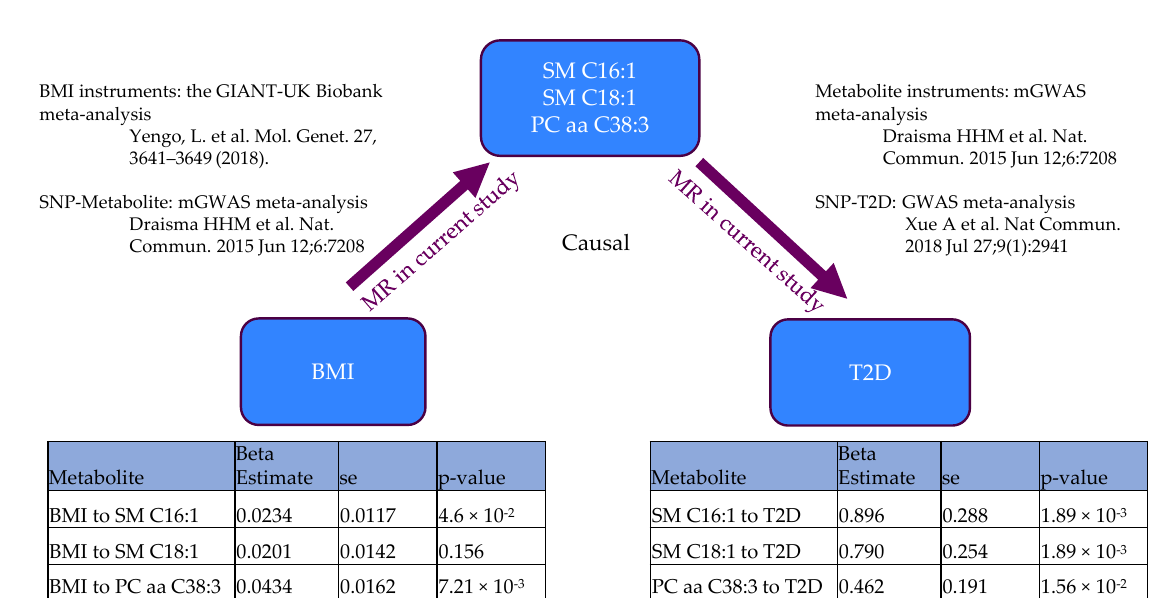
Figure 6. Schematic diagram is suggestive of relationships between BMI, metabolites and T2D. The studies we used for MR were listed in the figure. ß-estimate stands for beta coefficient, se stands for standard error